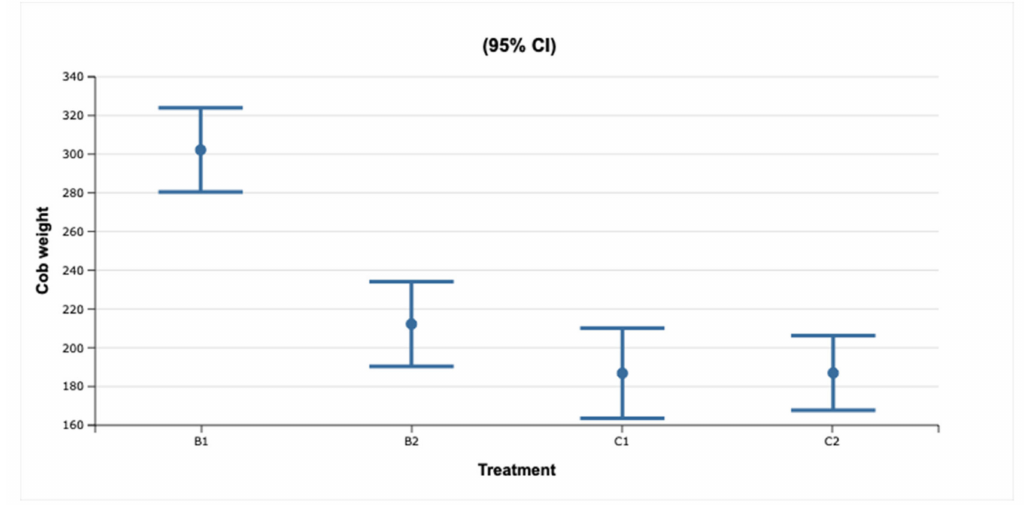
Figure 1. Average fresh cob weight in different treatment groups. Control: plots without biochar; B1: plots supplemented with biochar B1; B2: plots supplemented with biochar